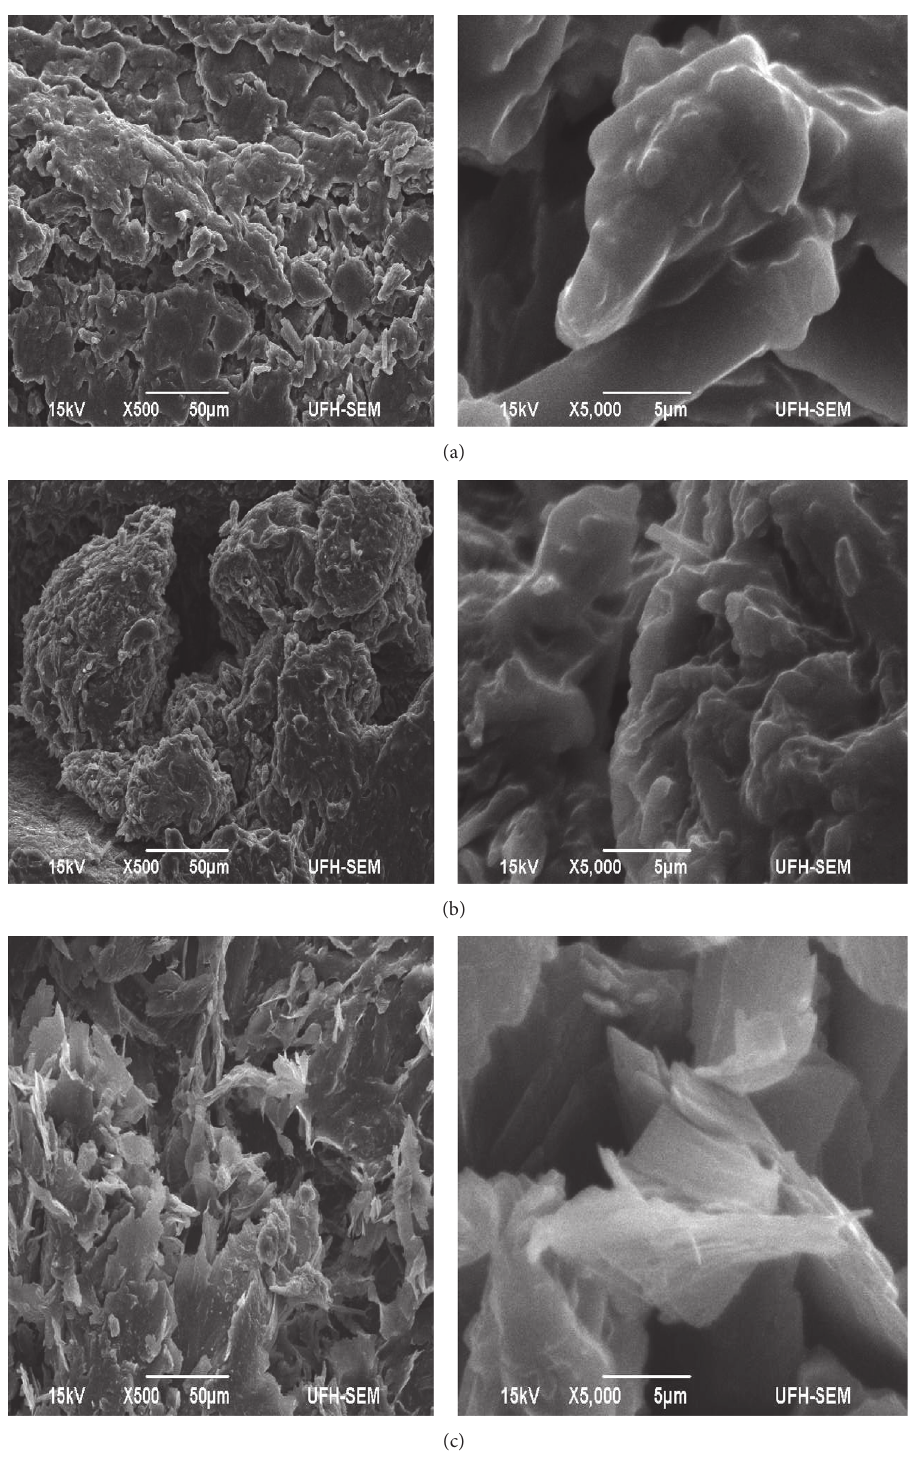
Figure 7: SEM images of NiS1 (a), NiS2 (b), and NiS